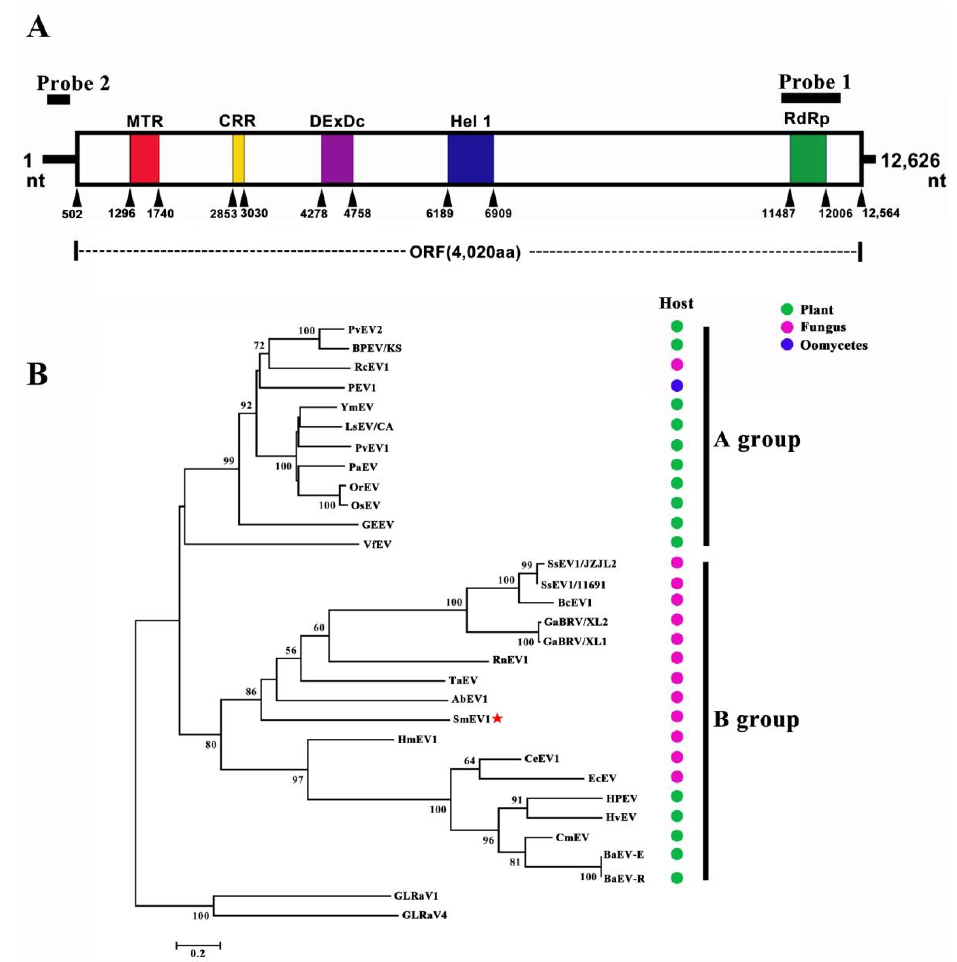
Figure 2. Genome characteristics and phylogeny of SmEV1. ( A ) A schematic diagram showing the genome organization of SmEV1. The coding stand of SmEV1 comprises one large open reading frame (ORF) coding for a polyprotein with the conserved domains of methyltransferase (MTR), cysteine-rich region (CRR), DEXDc, helicase 1 (Hel 1) and RNA-dependent RNA polymerase superfamily_2 (RdRp); ( B ) A maximum-likelihood tree showing the phylogenetic relationship of SmEV1 with 28 other endornaviruses. Grapevine leafroll-associated virus 1 and 4 (GLRaV1 and GLRaV4, GenBank Acc. Nos. ANP22157.1 and NC_016416.1, respectively) were used as outgroups. The tree was inferred from the RNA-dependent RNA polymerase (RdRp) domain. See Table 2 for abbreviation of the